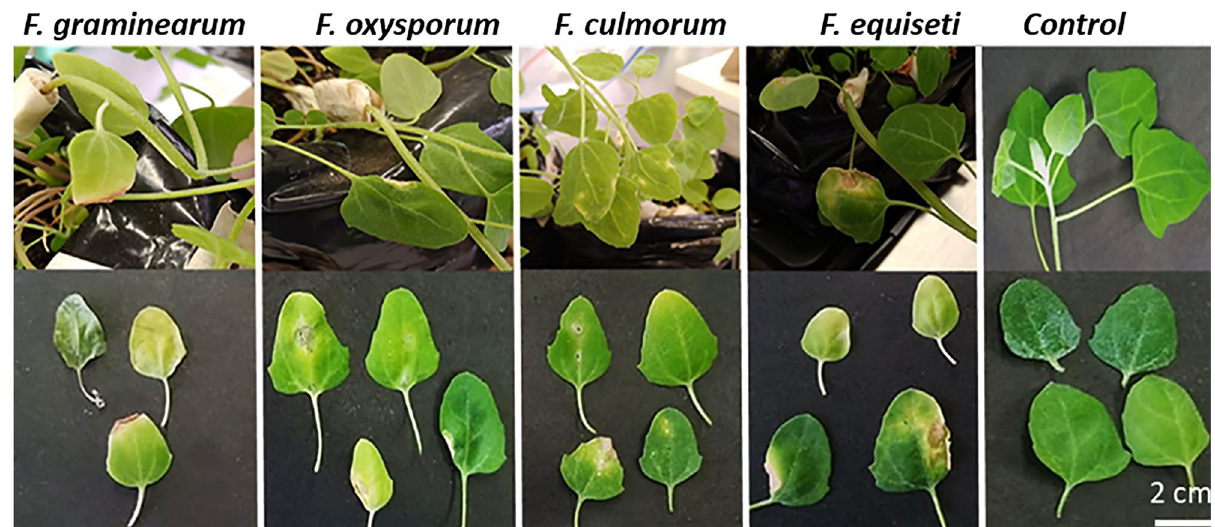
Figure 7. Symptomatology induced by F. graminearum , F. oxysporum , F. culmorum and F. equiseti in Piartal cv seedlings inoculated by wound method. The symptomatology is observed on the plant (above) and its detail in leaves (below). The control corresponds to leaves without fungal inoculum. Symptoms were observed after 90 days of inoculation.